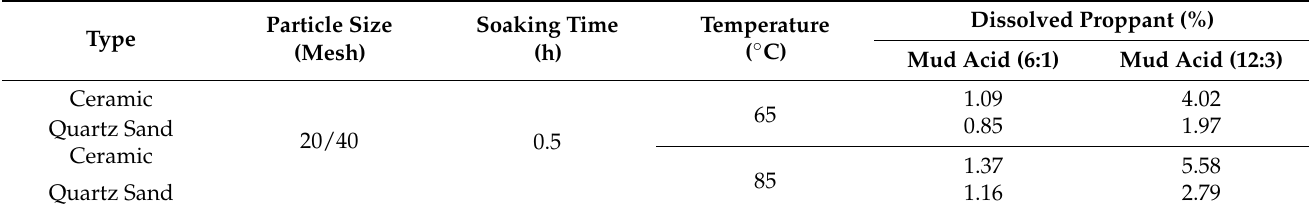
Table 1. Acid solubility of proppant under different temperature